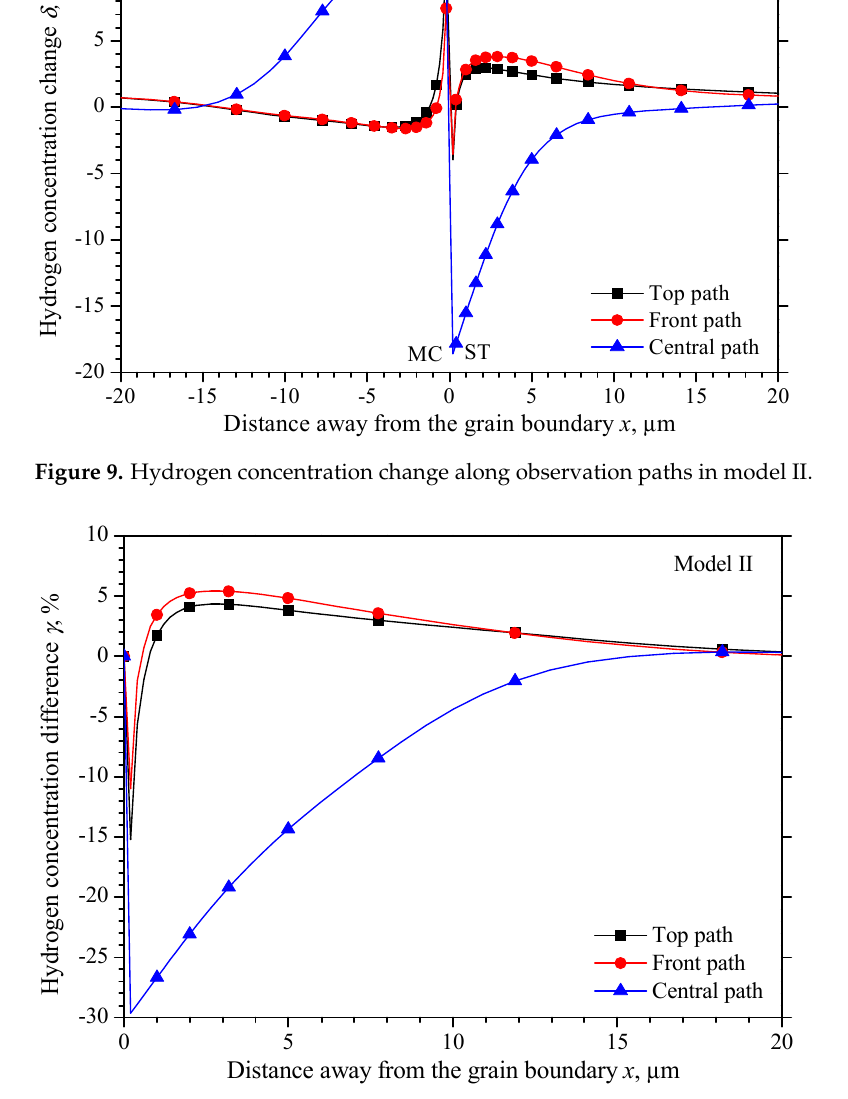
Figure 10. Hydrogen concentration difference equidistant from the grain boundary of model II.